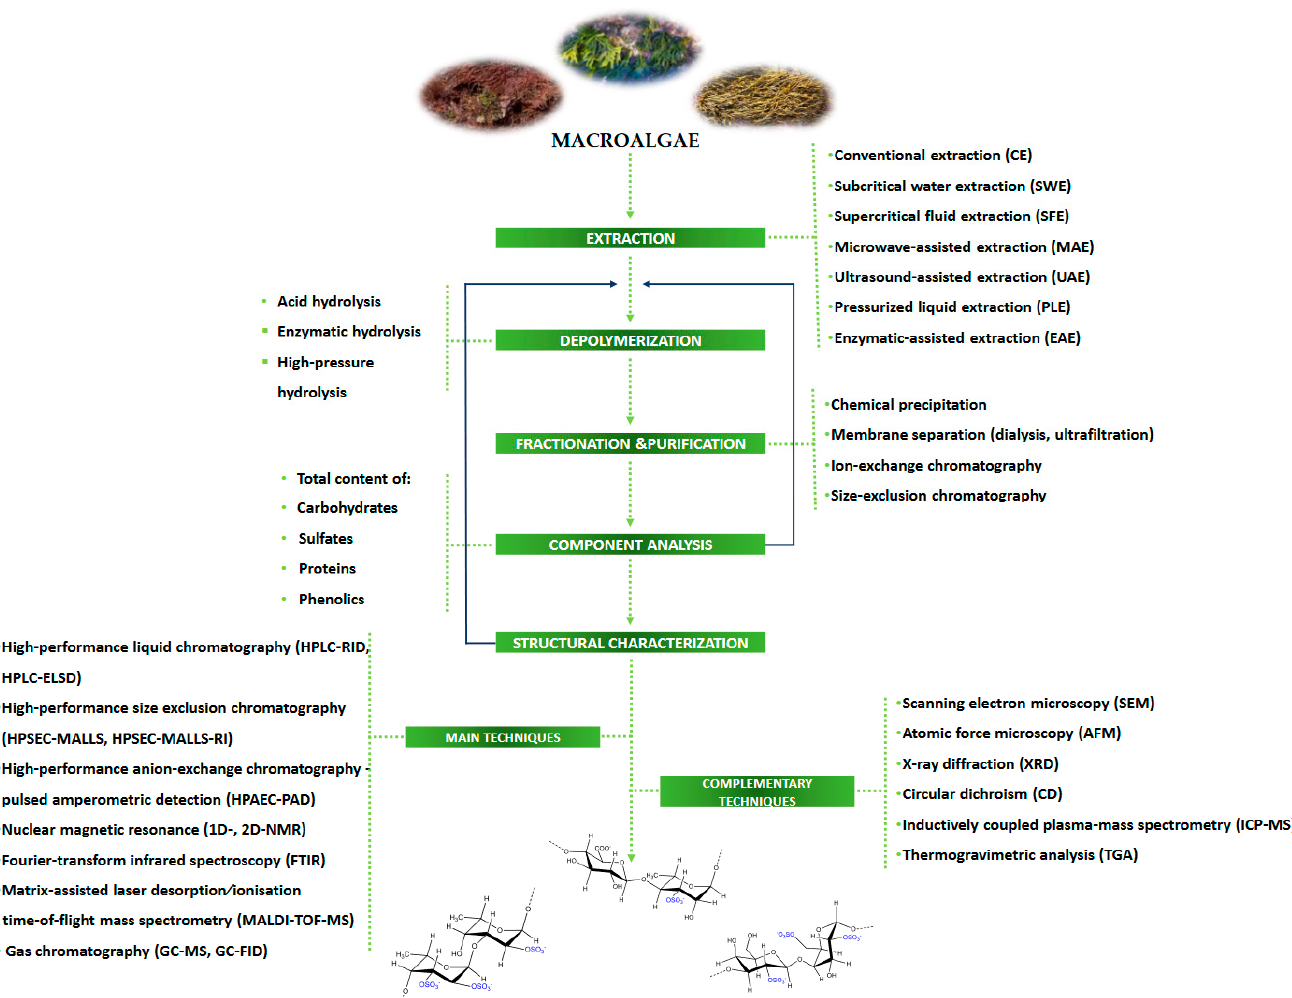
Figure 4. Roadmap of techniques/approaches for the chemical characterization of sulfated polysaccharides.